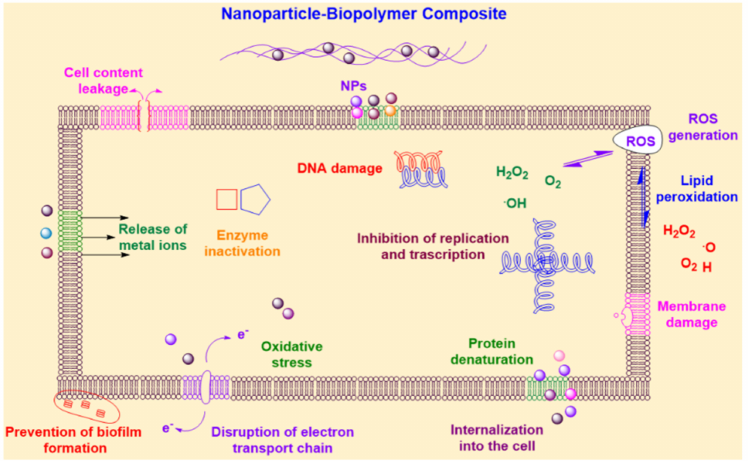
Figure 6. Schematic representation of antimicrobial mechanisms of action of nanocomposites de- signed for food